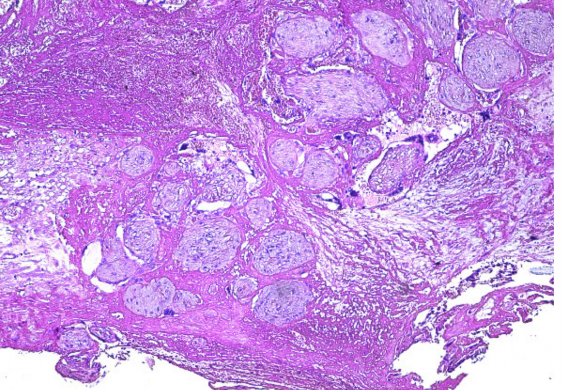
Figure 7. Marked fibrosis of chorionic villi, which invade the full thickness of the uterine wall (HE ×